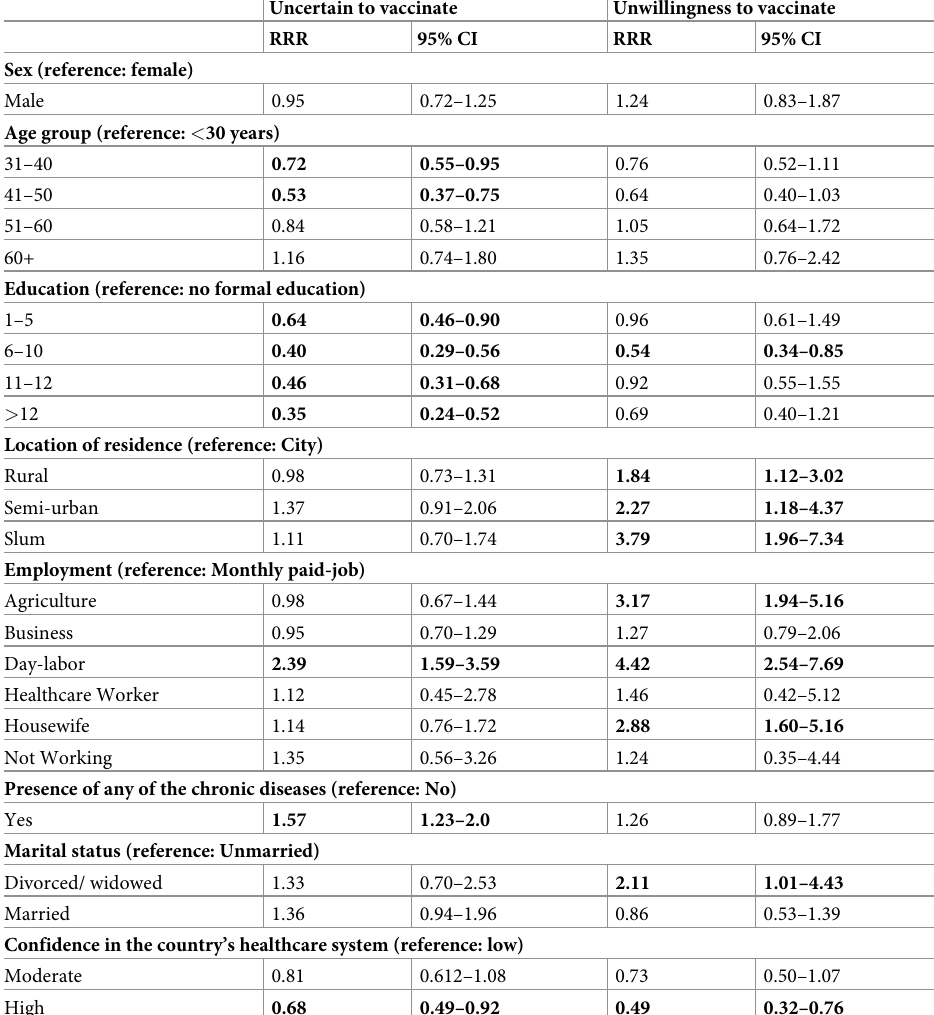
Table 3. Associated factors of uncertainty and unwillingness to vaccinate against COVID-19 using a multivariable multinomial regression. Uncertain to vaccinate Unwillingness to